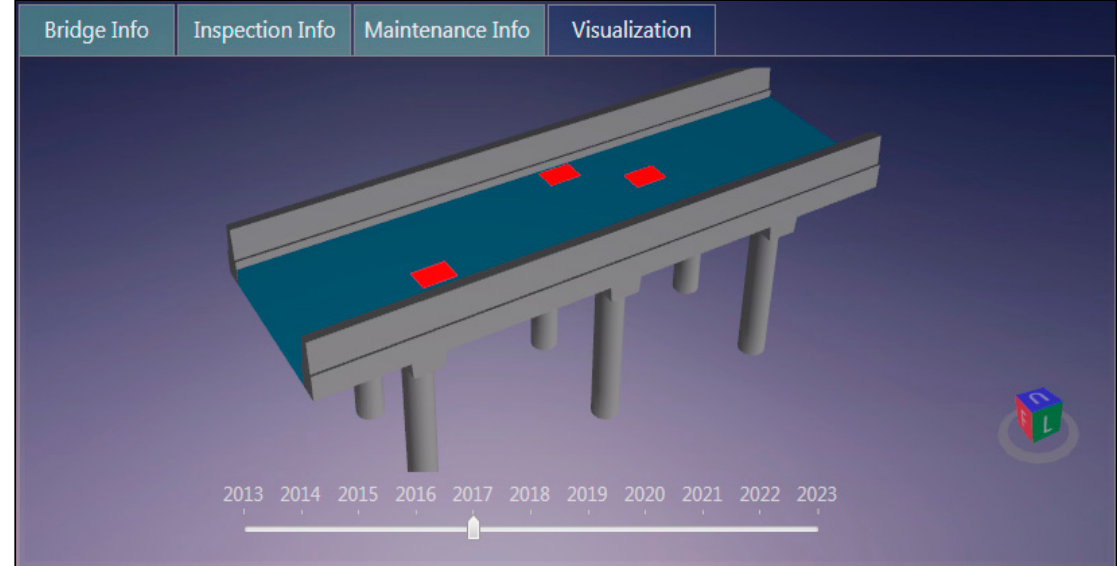
Figure 6. Visualization of NDE data and overlay of damage information.